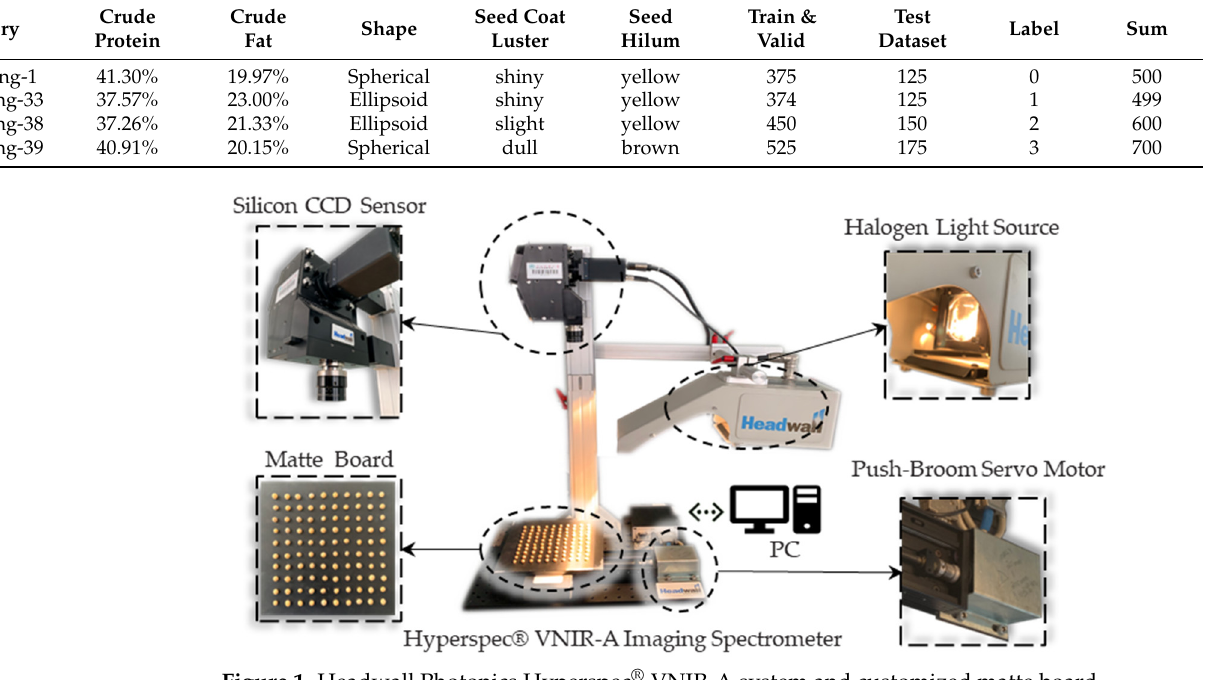
Figure 1. Headwall Photonics Hyperspec ® VNIR-A system and customized matte